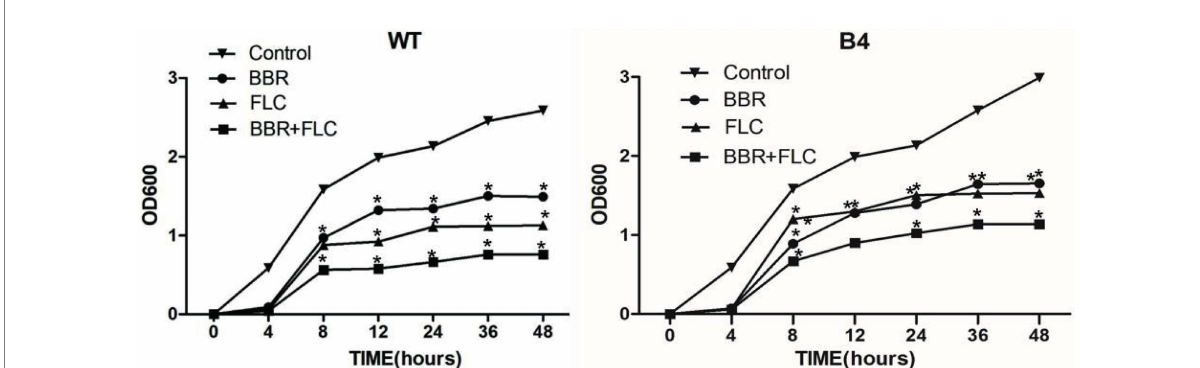
FIGURE 1 (WT) . Growth curve of T. marneffei type strain FRR 2161 treated with BBR and/or FLC Growth curves of the synergism of BBR with FLC againast T. marneffei type strain FRR 2161 that were obtained by using initial inoculums of 10 3 CFU/ml. BBR (32 μ g/ml); FLC (2 μ g/ml); BBR (32 μ g/ml) + FLC (2 μ g/ ml). (B4) . Growth curve of (B4) treated with BBR and/or FLC. BBR (32 μ g/ml); FLC (256 μ g/ml); BBR (32 μ g/ml) + FLC (256 μ g/ml). * p < 0.05 compared with the control.